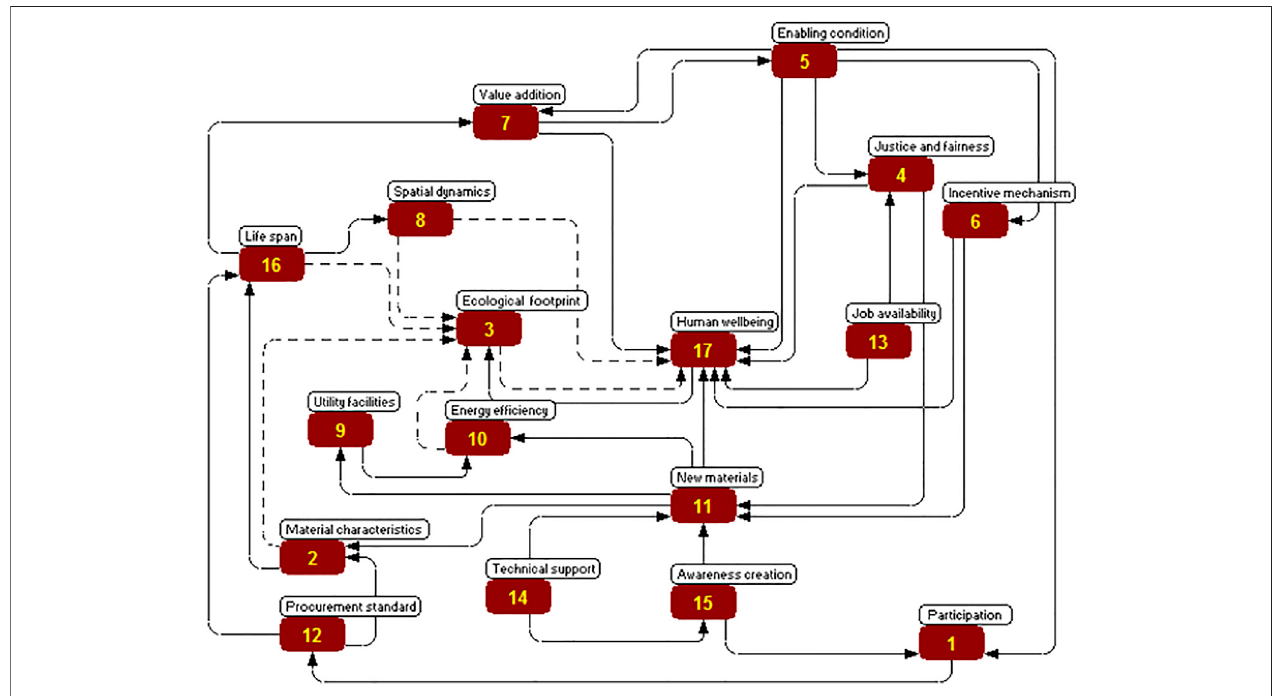
FIGURE 5 | Effect system of the